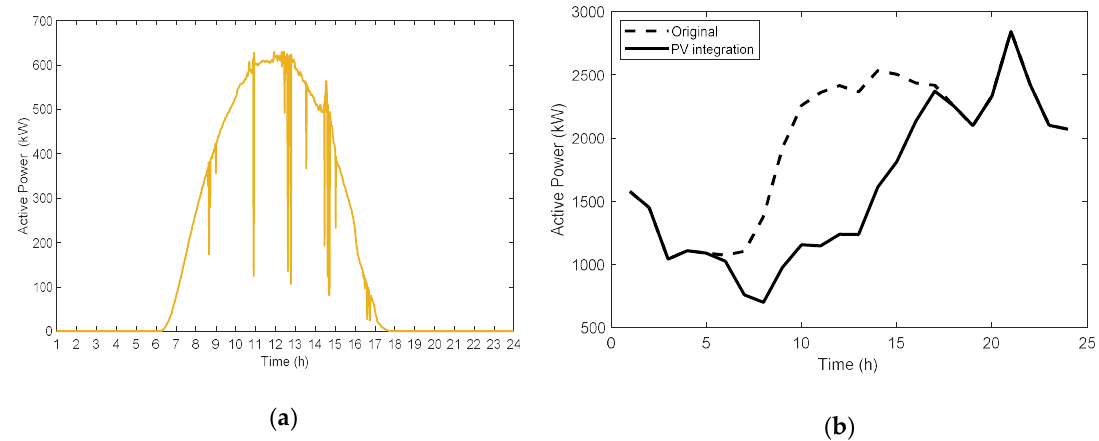
Figure 6. PV generation. ( a ) Aggregated PV generation profile. ( b ) Total load with and without PV generation.